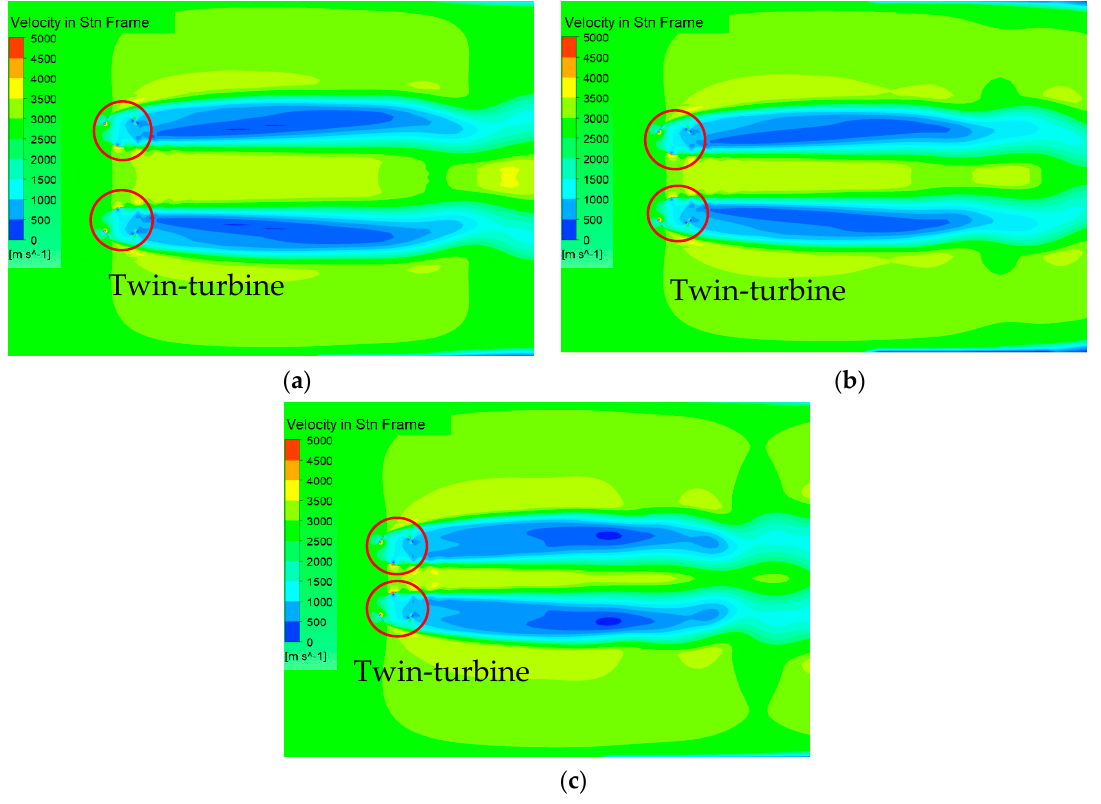
Figure 18. Cloud picture of velocity in twin-rotors system field with various axis distances. ( a ) Relative distance DIST = 11/4, ( b ) Relative distance DIST = 9/4, ( c ) Relative distance DIST = 7/4.